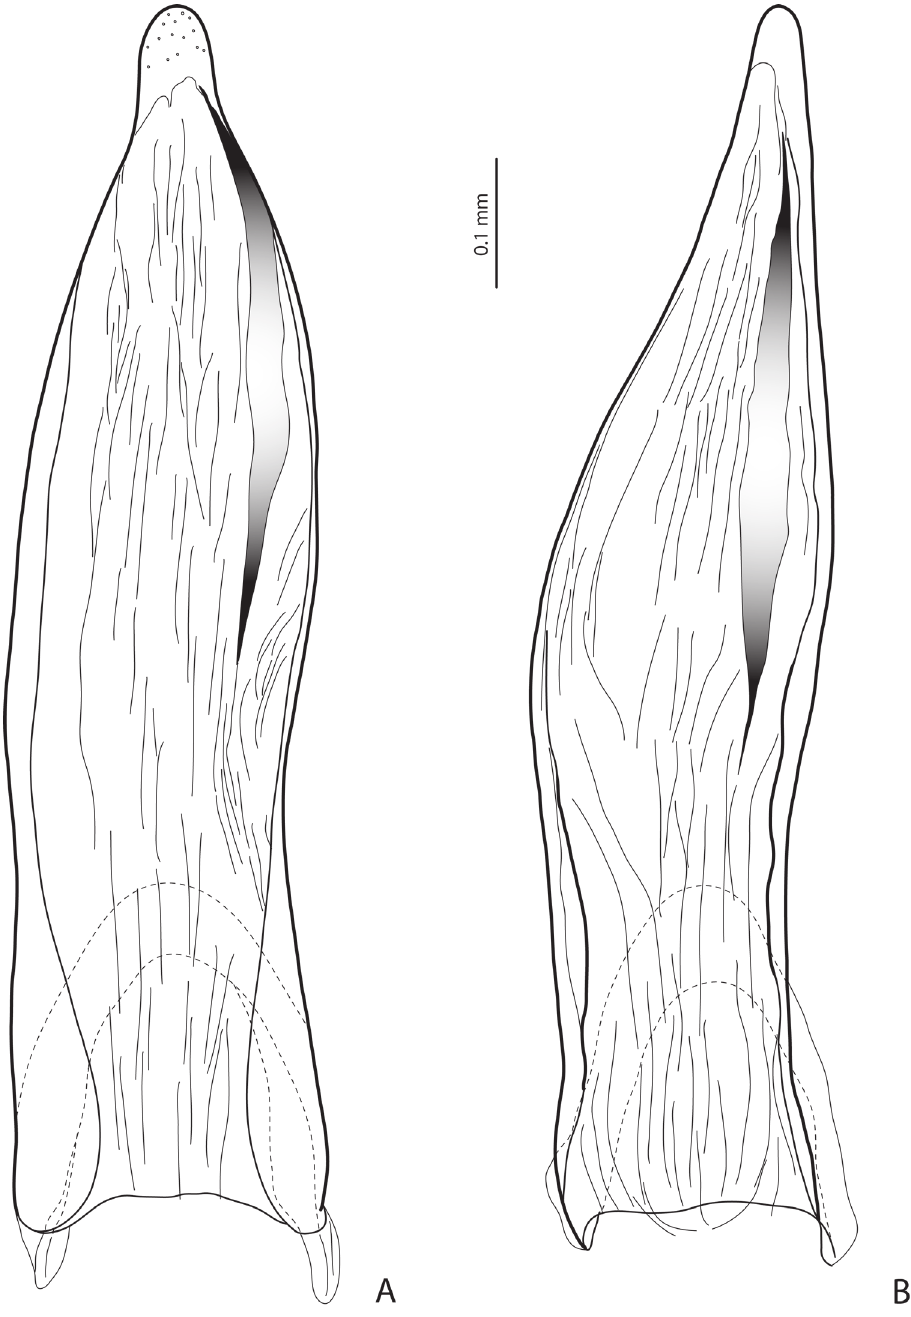
Figure 5. Median lobe in ventral view A Exocelina baliem sp. n. B E. ferruginea (Sharp,